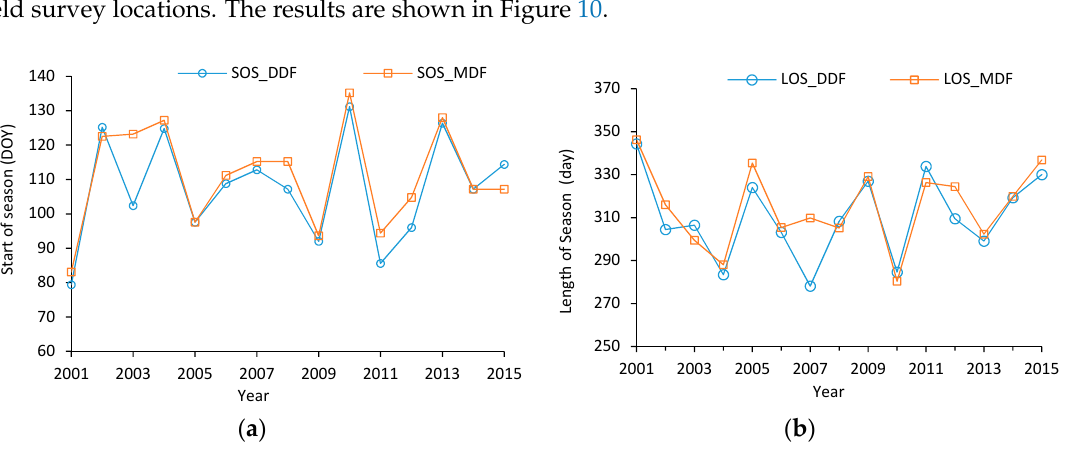
Figure 10 . Inter-annual variations of tropical deciduous forest phenology metrics in different forest types period 2000 – 2015; ( a ) Start of growing season (SOS); ( b ) length of growing season (LOS).